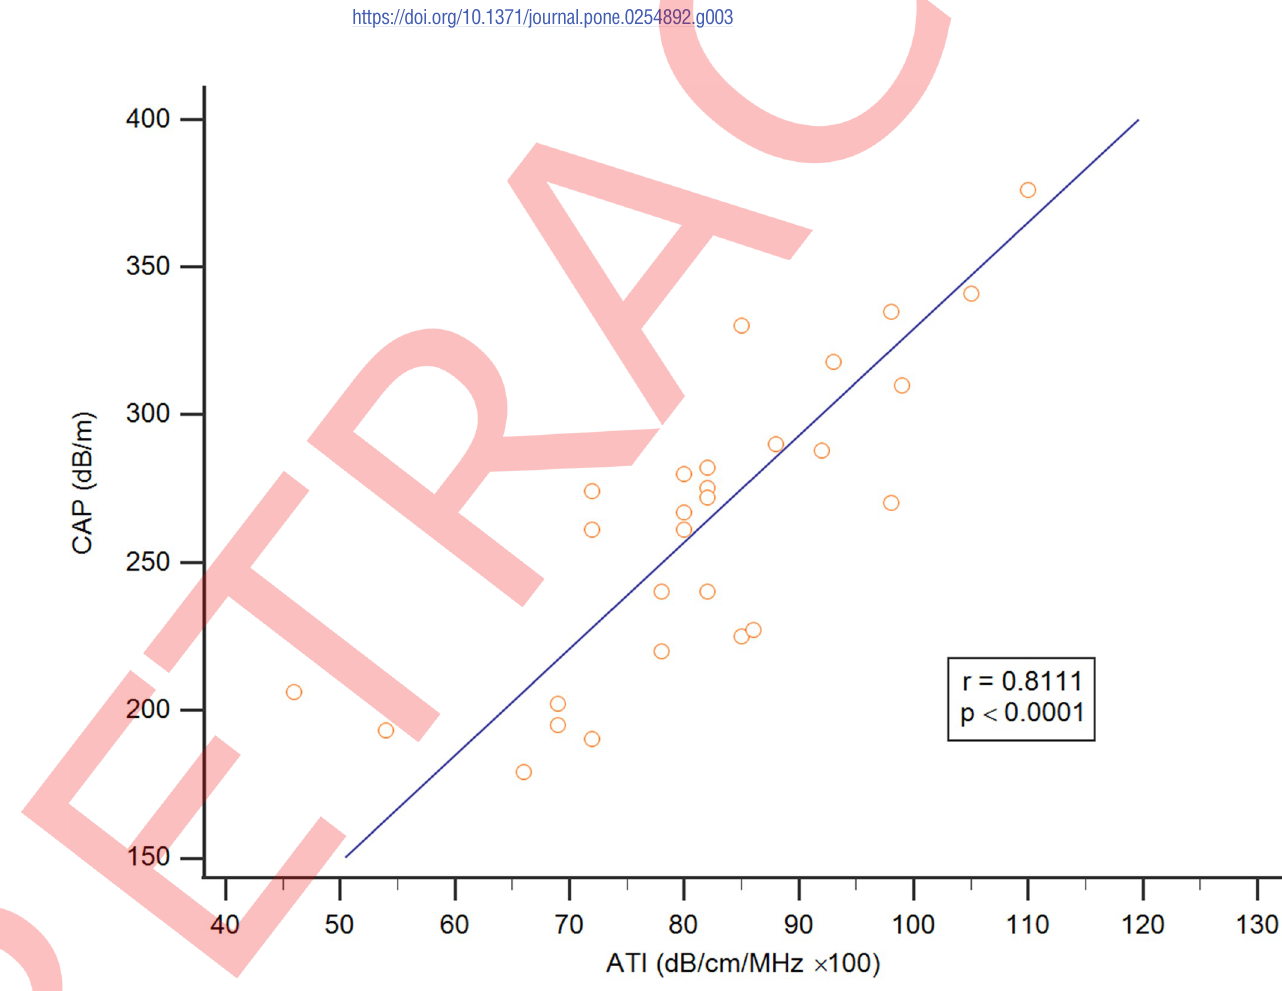
Fig 4. The association between ATI and CAP. ATI and CAP were significantly correlated (r = 0.8111; p < 0.05).